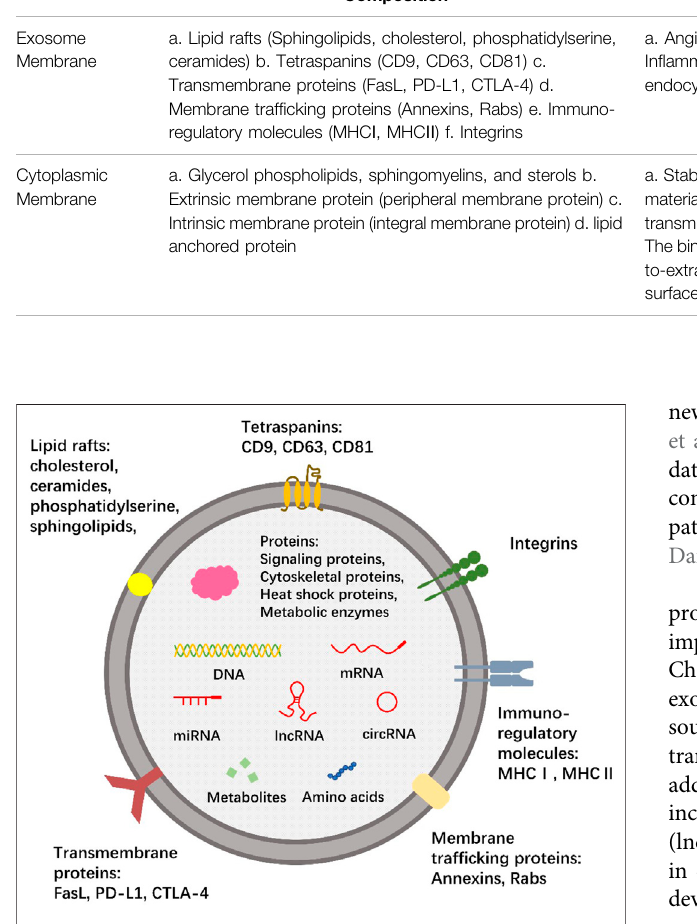
FIGURE 1 | The composition of exosomes. The membrane of exosomes, like cells, iscomposed of the phospholipid bilayer. The membrane surface contains a wide range of tetraspanins (CD9, CD63, CD81), transmembrane proteins (FasL, PD-L1, CTLA-4), membrane traf fi cking proteins(Annexins,Rabs),integrinsandimmuno-regulatorymolecules(MHC Ⅰ , MHC Ⅱ ) that bind speci fi c peptide chains. There are also several lipid rafts involved, such as phosphatidylserine, sphingolipids, cholesterol, and ceramides. Exosomes contain a variety of nucleic acids, including not only DNA and mRNA, but also many ncRNAs, including miRNA, lncRNA and circRNA. Some proteins, amino acids, and metabolites can also be encapsulated in exosomes. This is a typical but not comprehensive representation ofexosomes, and nosingleexosomeisexpectedtocontain all or even most of the bioactive molecules